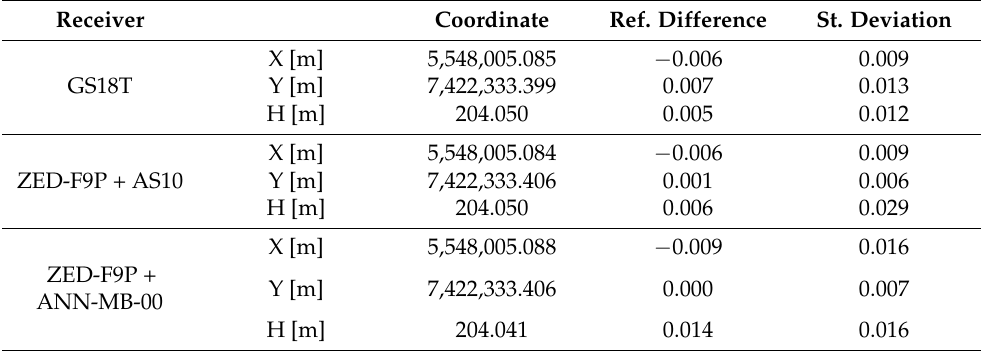
Table 3. Measurement results on Pt 2.